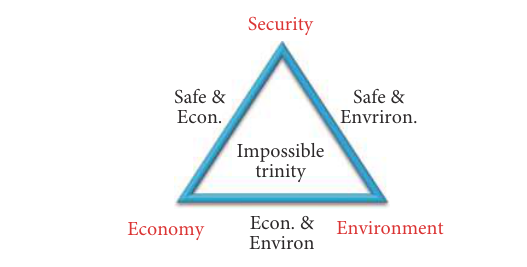
Fig. 5 Full-load hours (FLHs) of wind and photovoltaic (PV) power